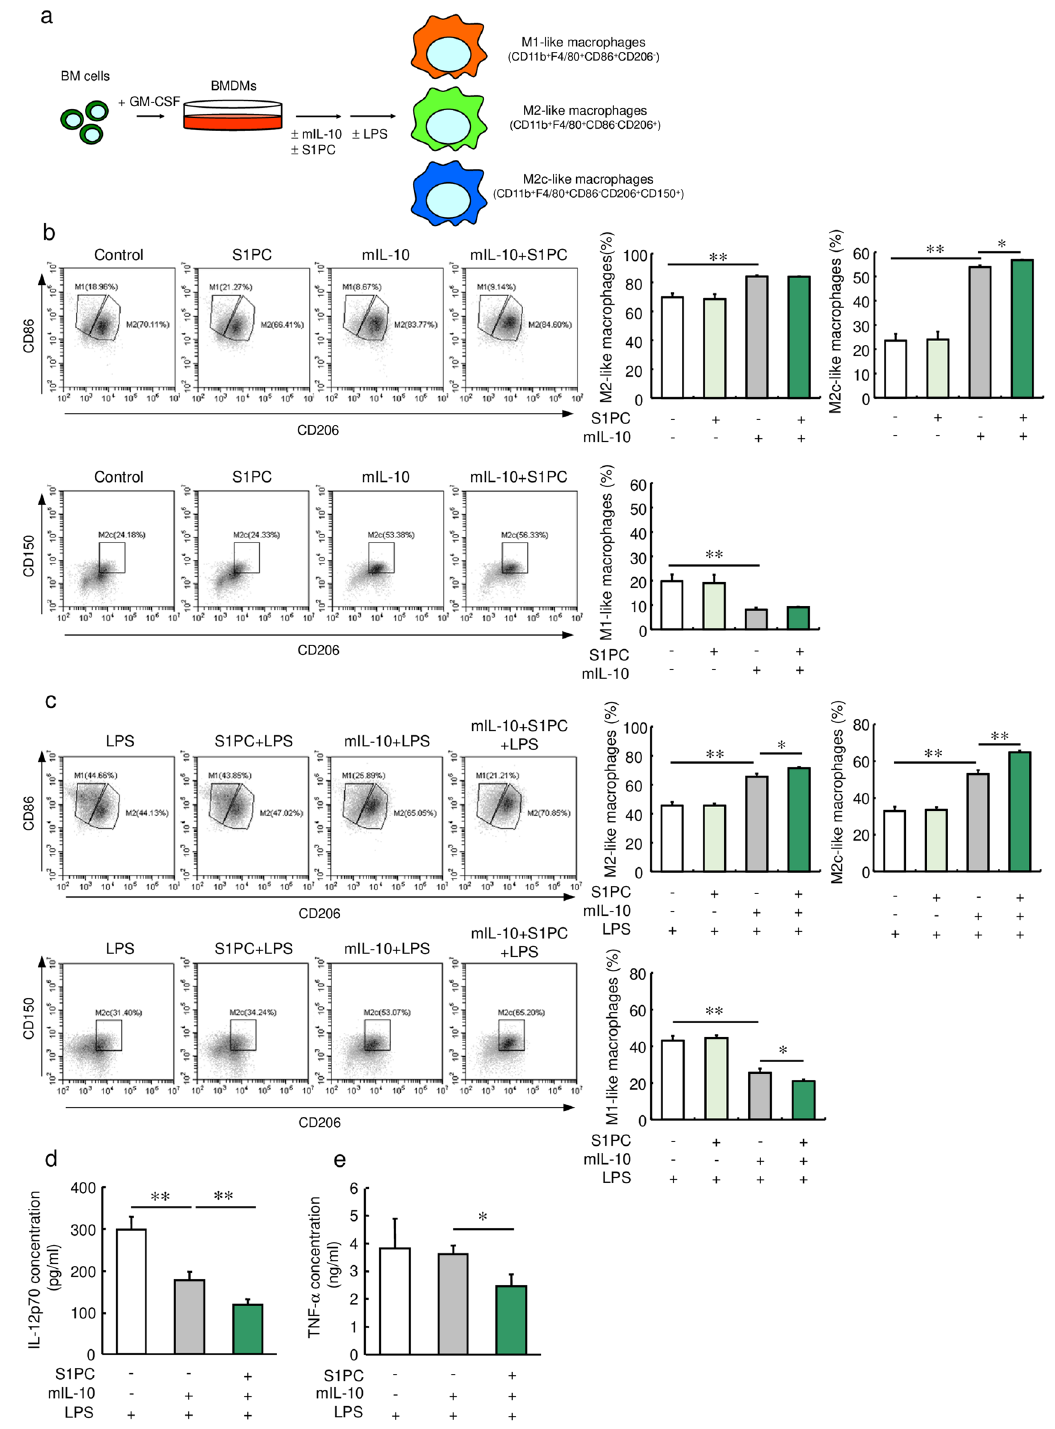
Figure 3. Effect of S1PC on IL-10-induced macrophage polarization in GM-CSF-induced BMDMs. ( a ) Assay scheme. ( b ) GM-CSF-induced BMDMs were treated with S1PC (300 µM) in the presence or absence of mIL-10 (30 ng/mL) for 48 h. The populations of M1-like macrophages (CD11b + , F4/80 + , CD86 + , and CD206 - cells), M2-like macrophages (CD11b + , F4/80 + , CD86 - , and CD206 + cells), and M2c-like macrophages were analyzed using flow cytometry. ( c – e ) GM-CSF-induced BMDMs were treated with S1PC (300 µM) in the presence or absence of mIL-10 (30 ng/mL) for 48 h. Then, they were washed with PBS and treated with LPS (100 ng/mL) for 16 h. ( c ) The populations of M1-like macrophages, M2-like macrophages, and M2c-like macrophages were analyzed using flow cytometry. The amounts of ( d ) IL-12p70 and ( e ) TNF-α secreted into the culture media were determined using ELISA. Data are shown as mean + SD. Data are representative of three independent experiments. Statistical differences were determined using Bonferroni’s multiple comparison test (* p < 0.05 and ** p <